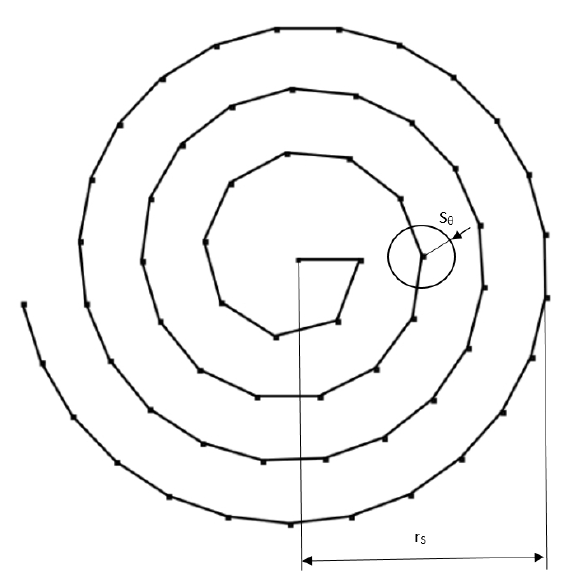
Figure 11. Correction of the telescope axis motion based on the modified Archimedean